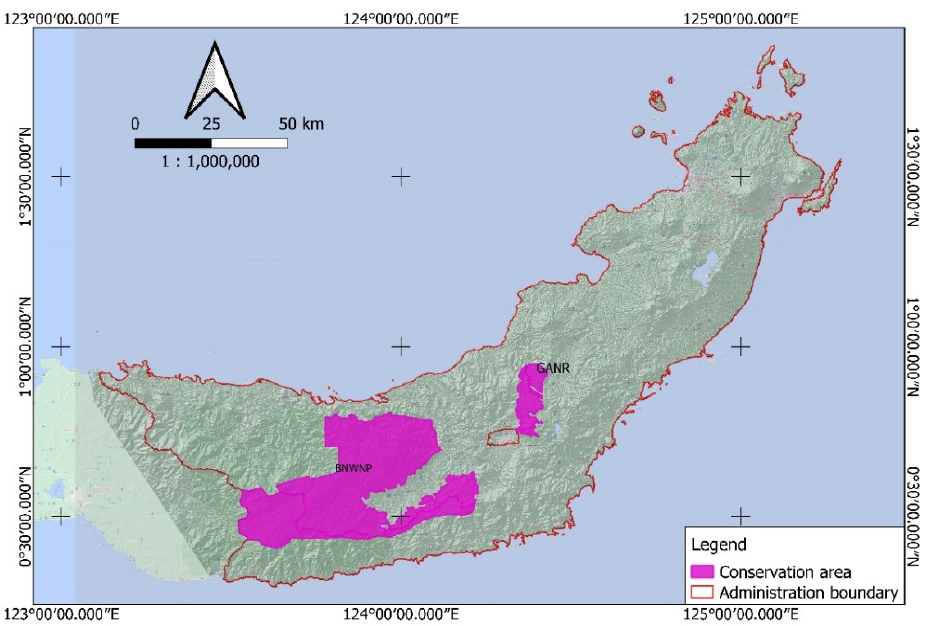
Figure 1. Study area in the northern part of Sulawesi: The purple color represents conservation areas of Bogani Nani Wartabone National Park (BNWNP) and the Gunung Ambang Nature Reserve (GANR).